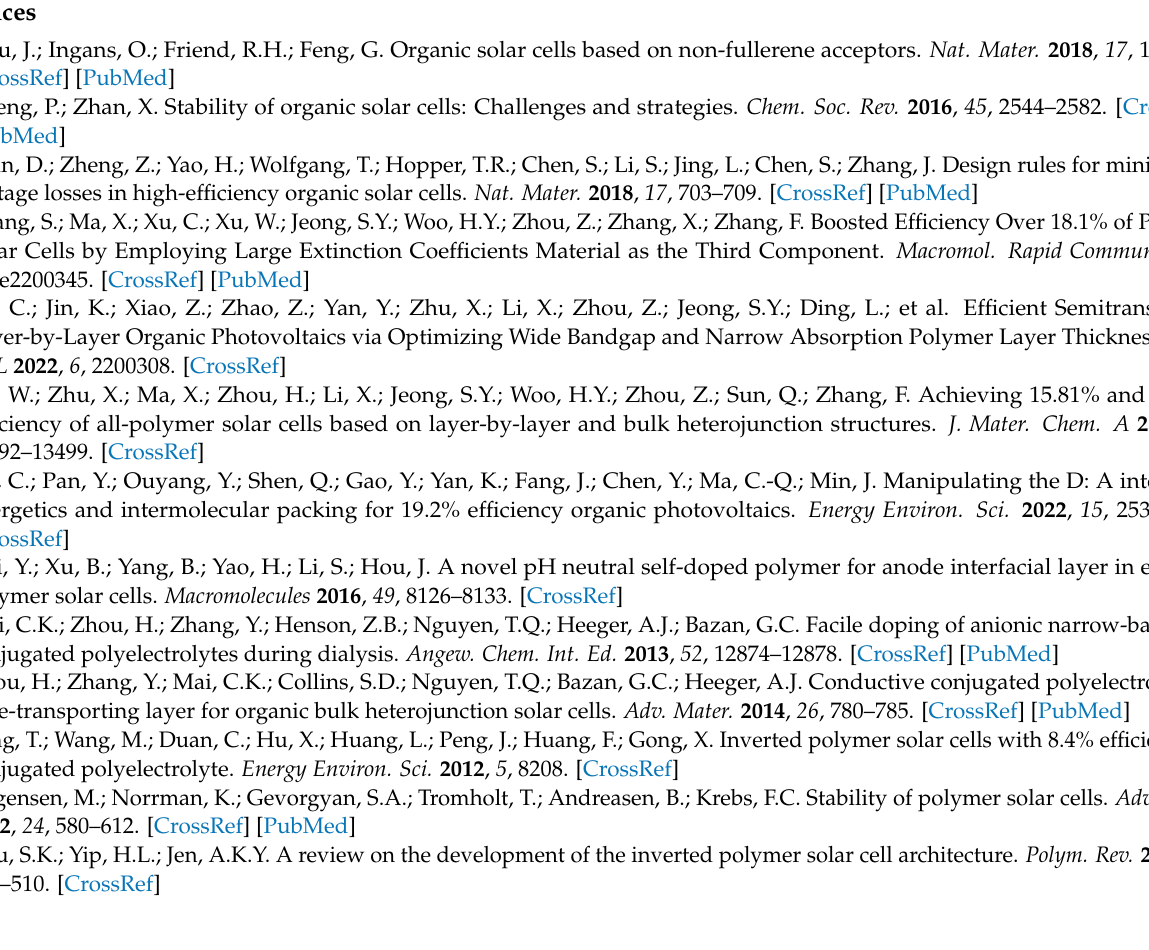
Figure S1: J-V characteristics curves of OSCs with methionine as ETL under different concentrations of methionine solution, Figure S2: ( a ) CPD data and ( b – f ) CPD images of ITO modified by different ETLs captured in KPFM, Figure S3: ( a ) Transmission spectra of different ETLs films and ( b ) different ETLs/active layer films, Figure S4: ( a ) Line scanning height of the AFM images of PM6:BTP-ec9 films spin-coated on ITO, ITO/methionine, ITO/ZnO, and ITO/ZnO/methionine; ( b ) surface height histogram extracted from corresponding AFM image, Figure S5: ( a ) Shows a typical plot of log (J) versus log (V) curves obtained when holes are injected into a hole-only device, and ( b ) shows the same curve when electrons are injected into a purely electronic device. The dotted line represents the slope, Figure S6: ln(JL3/V2)-(V/L)0.5 curves for the SCLC fitting of ( a ) hole-only devices with the structure of ITO/PEDOT:PSS/active layer/MoO3/Al and ( b ) electron-only devices with the structure of ITO/ETL/active layer/PDIN/Al, Figure S7: J-V curves of OSCs with ZnO or ZnO/methionine as ETLs under AM 1.5G illumination with the light intensities of 100, 79, 50, 39.5, 25, 12.5, or 10 mW cm − 2 , respectively, Figure S8: ( a ) JSC and ( b ) VOC dependence on the light intensity of OSCs with ZnO or ZnO/methionine as ETLs, Figure S9: Normalized PCE versus storage time for ZnO or ZnO/methionine-based OSCs stored in a high-purity nitrogen-filled glovebox. Author Contributions: Y.X. and H.Z. conducted the majority of the experiments and analyzed the data. P.D., B.S. and W.X. performed some experiments. J.W. and M.L. helped with data analysis and provided funding for the study. F.Z. and Q.S. designed the study, interpreted the data, and provided resources and funding for the study. All authors contributed to the manuscript writing. All authors have read and agreed to the published version of the